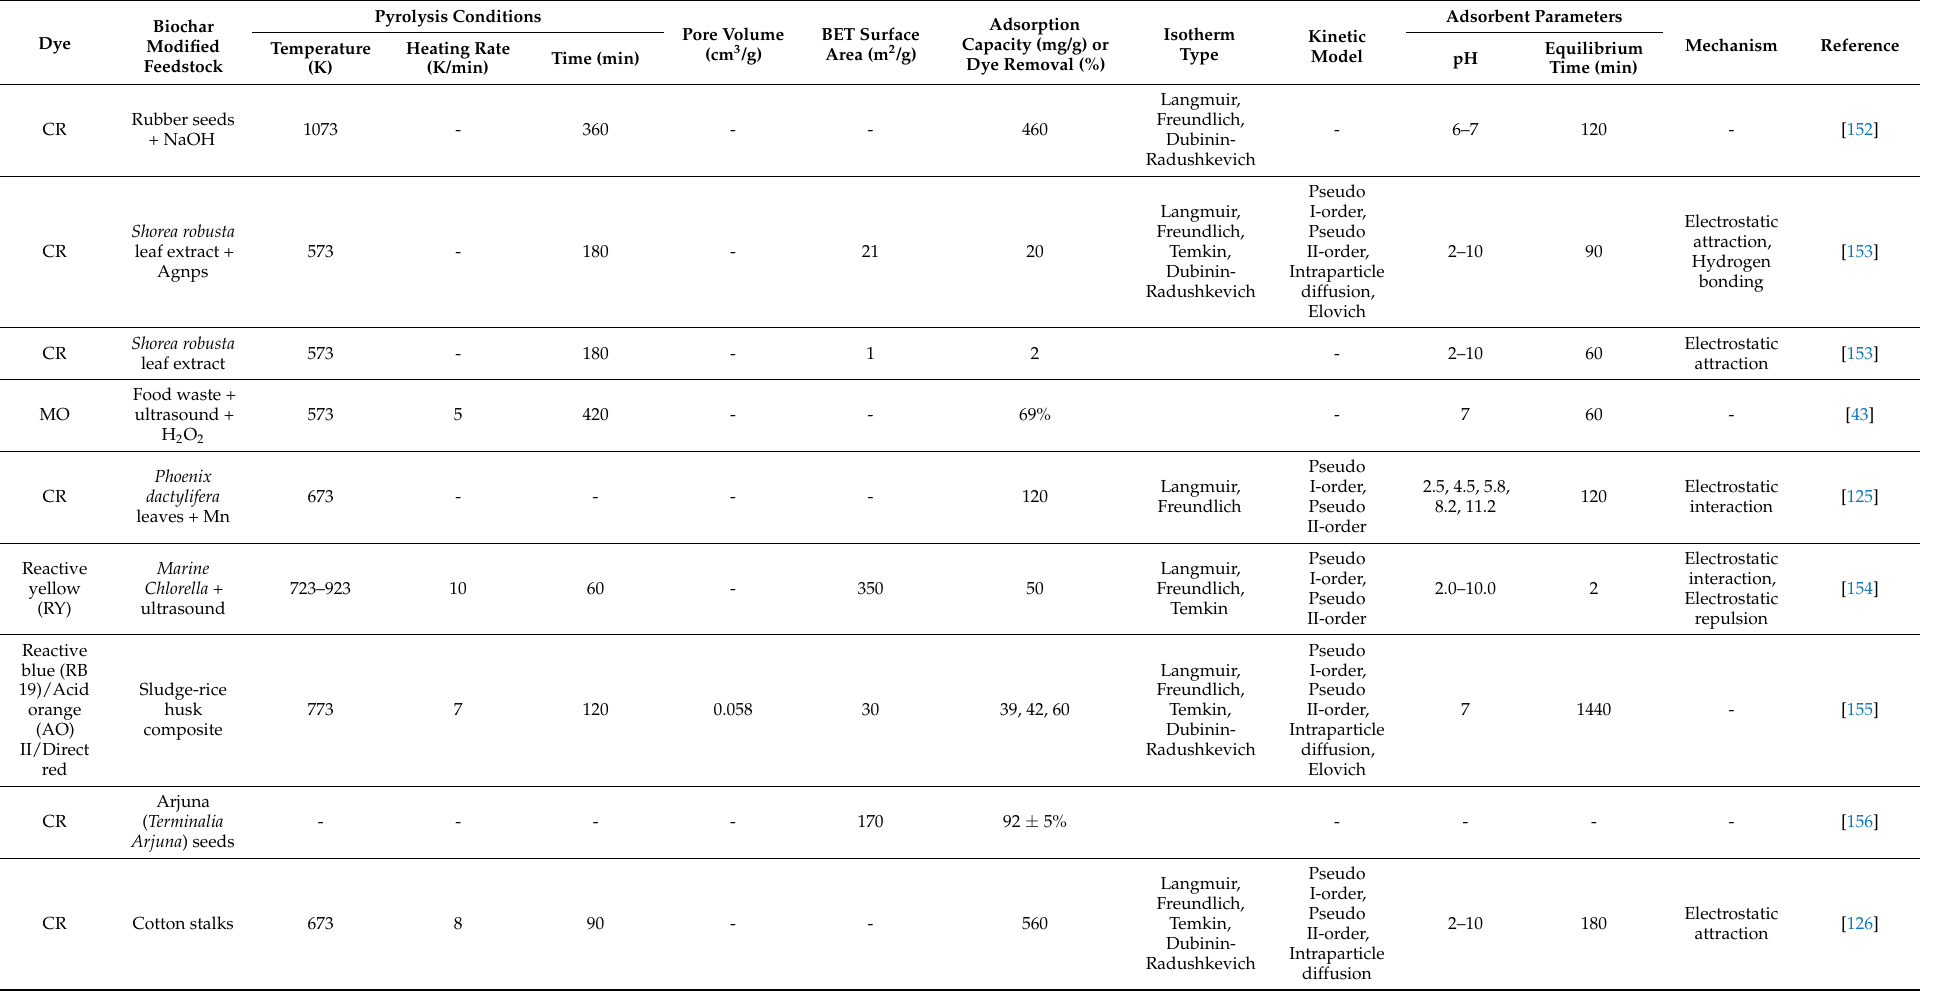
Table 4. Acid dyes (anionic) and their adsorption onto modified (altered)